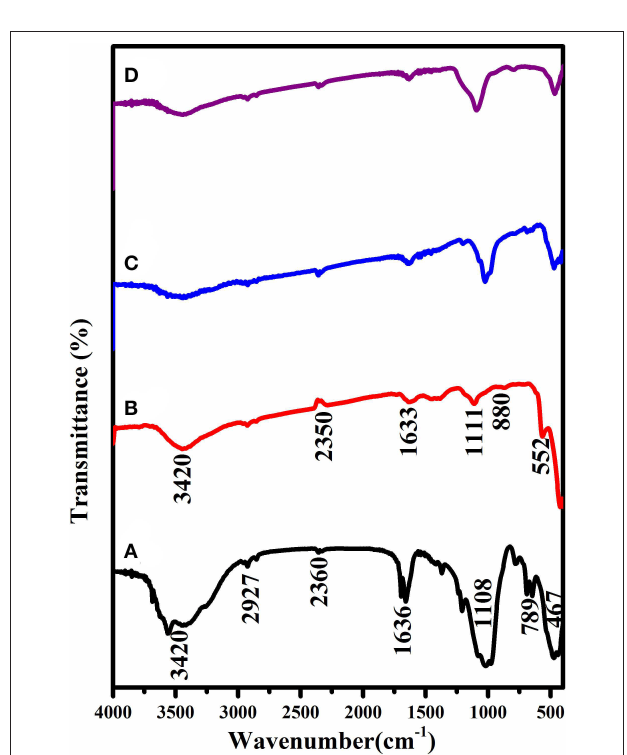
FIGURE 3 | FTIR spectra of (A) SSp, (B) ZnO, (C) S/SvSp/ZnO, and (D) S/PTSp/ZnO.